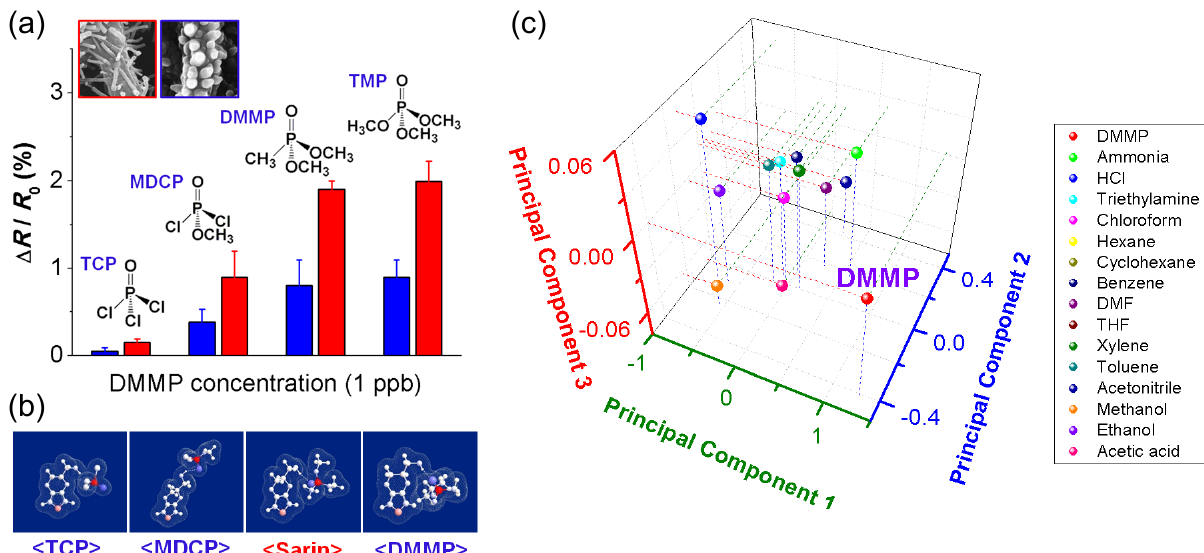
Figure 8. Sensing performance of chemical nerve agent sensor based on hydroxylated PEDOT nanotubes (HPNTs). ( a ) Histogram showing the response of HPNTs toward similar organophosphorus compounds at 1 ppb (TCP, MDCP, DMMP, TMP); ( b ) 3D graphics showing the formation of hydrogen bonds between nerve agent stimulant molecules and HEDOT; ( c ) Principal components analysis plot using response intensity inputs from four different conducting polymer nanomaterials (two different HPNTs, pristine PEDOT nanotubes, and PPy nanotubes) to the 16 analytes (including DMMP): each analyte concentration was fixed at around 4 ppm. With permission from [59]; Copyright 2012, American Chemical Society.